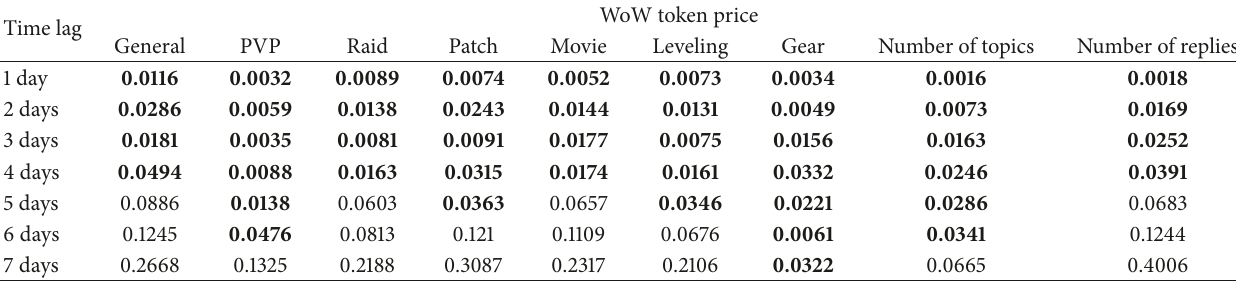
Table 3: Statistical significance ( 𝑝 values) of bivariate Granger causality test between WoW token price (NA Region) and concepts of forum opinions.